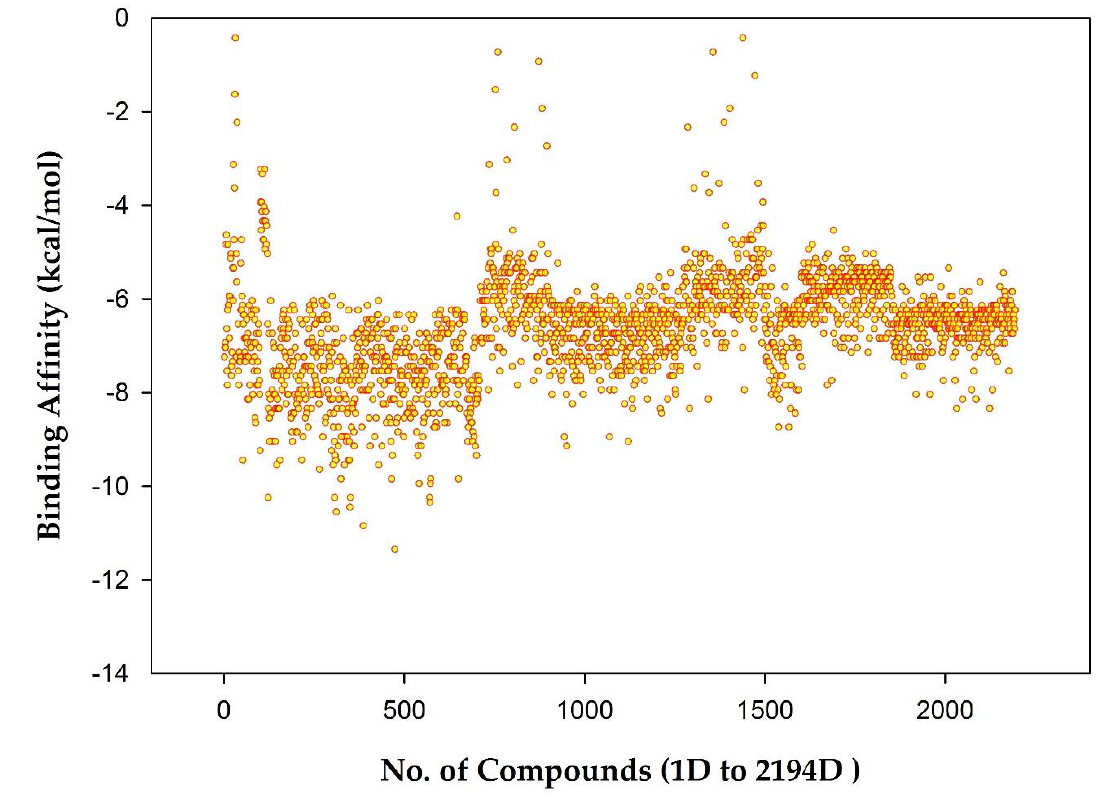
Figure 4. The docking site (grey/white colour) of the LuxP protein in V. carchariae .